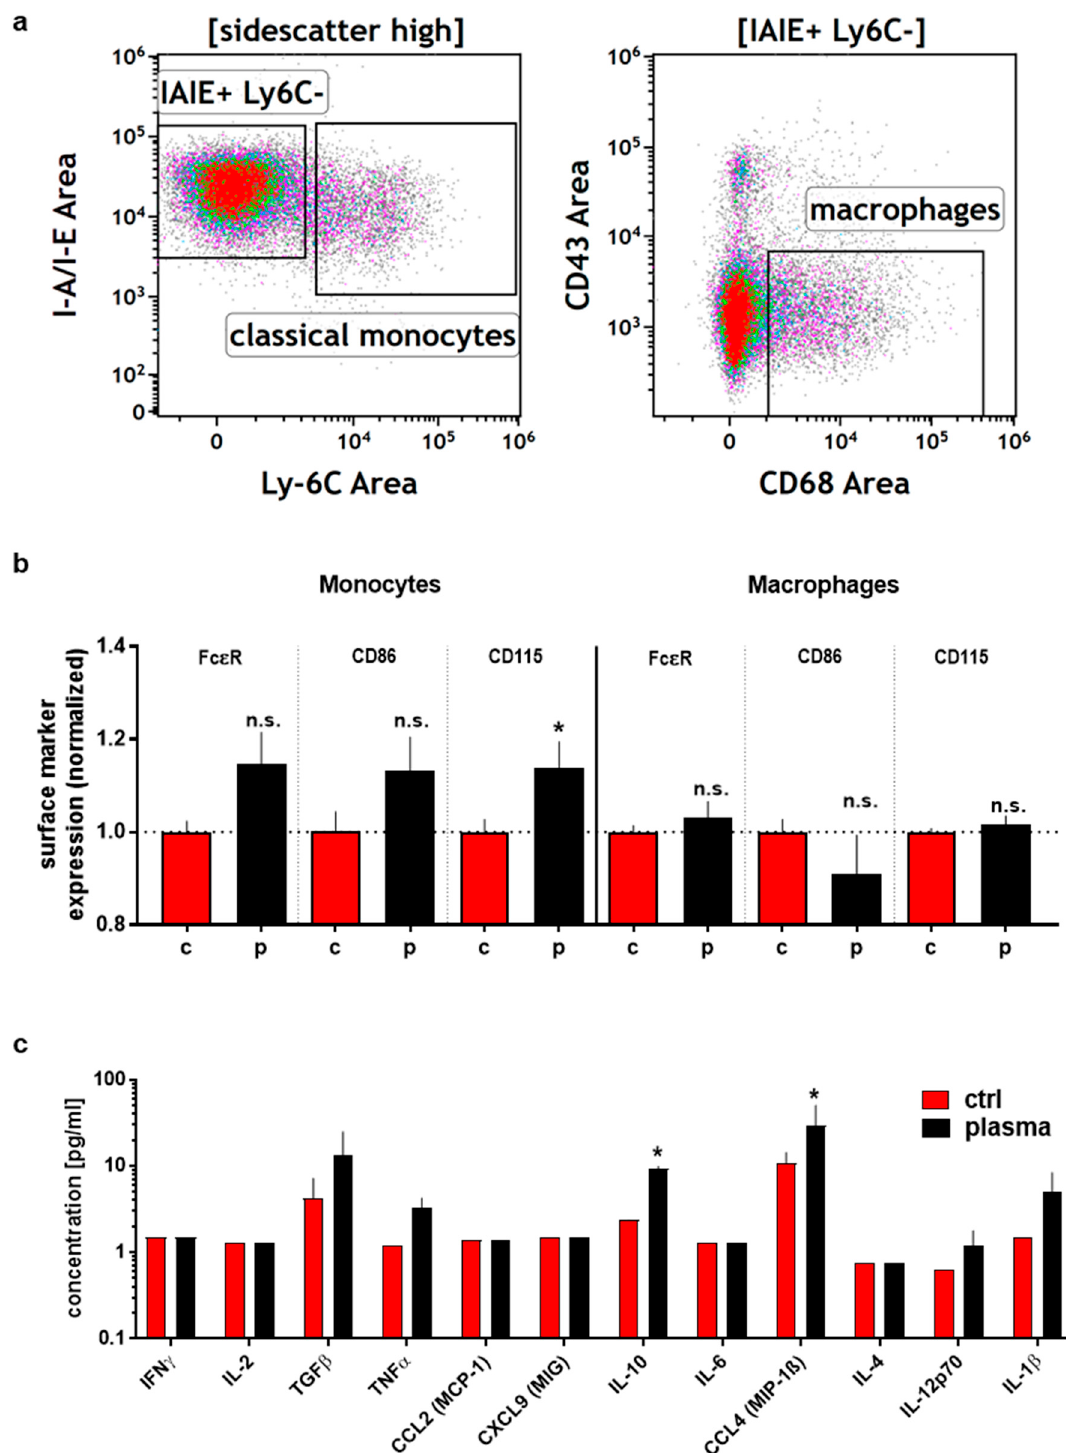
Figure 5. Activation of monocyte and macrophage splenocyte subpopulations after co-culture with melanoma cells. ( a ) Representative gating strategy to identify monocytes and macrophages within splenocytes; ( b ) of change expression of activation marker expression in monocytes/macrophages 24 h after co-culture with either control (C) or plasma-treated (P) melanoma cells; ( c ) cytokine profile supernatants retrieved from transwell co-cultures of control or plasma-treated melanoma cells with splenocytes. Data are presented as mean + S.E. of several spleens; statistical analysis was performed using t